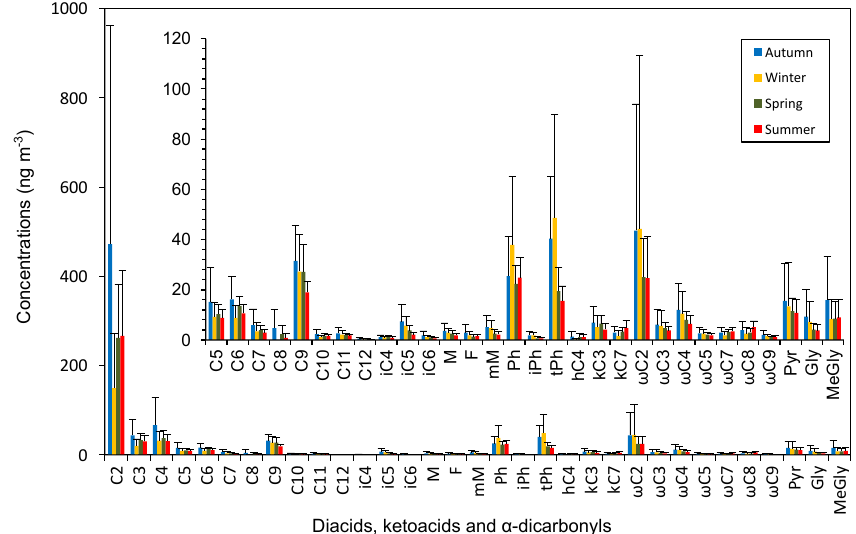
Figure 2. Molecular distributions of dicarboxylic acids and related compounds in the PM 2 . 5 samples collected in Beijing from September 2013 to July